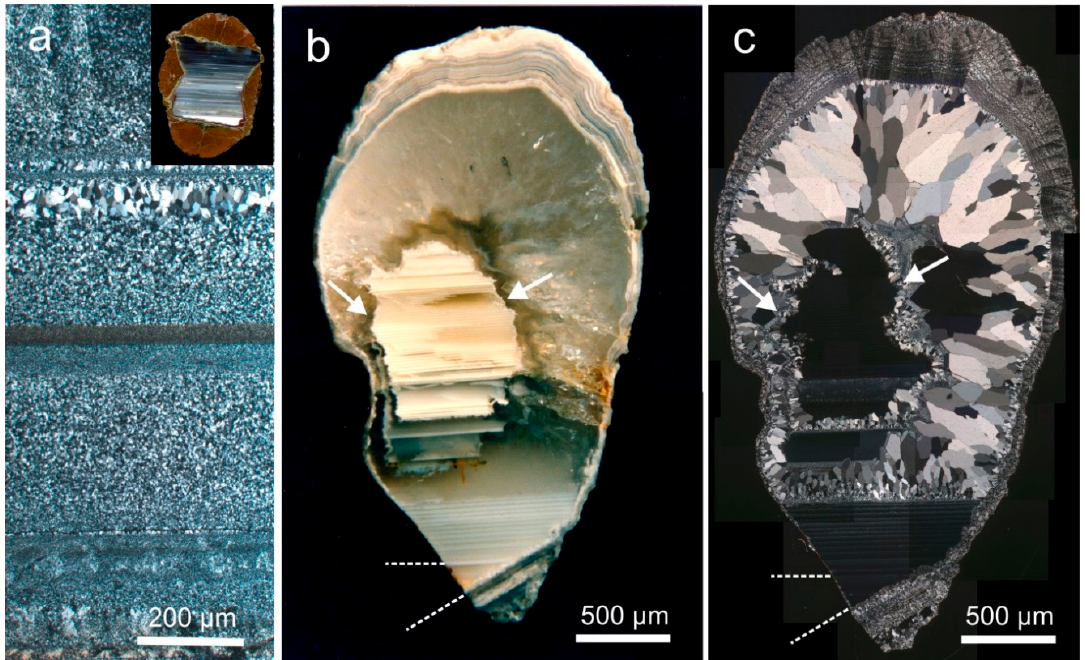
Figure 9. ( a ) Transmitted light (crossed polars) micrograph of an “Uruguay agate” from the Richardson Ranch (Oregon, USA, see inset); the different horizontal layers show strong variations in crystallite size ( b , c ) agate from Gröppendorf (Saxony, Germany) as original sample ( b ) and in transmitted light (crossed polars, ( c )) with tilted horizontal layers and ongoing re ‐ crystallization of quartz replacing former horizontal bands (see arrows).